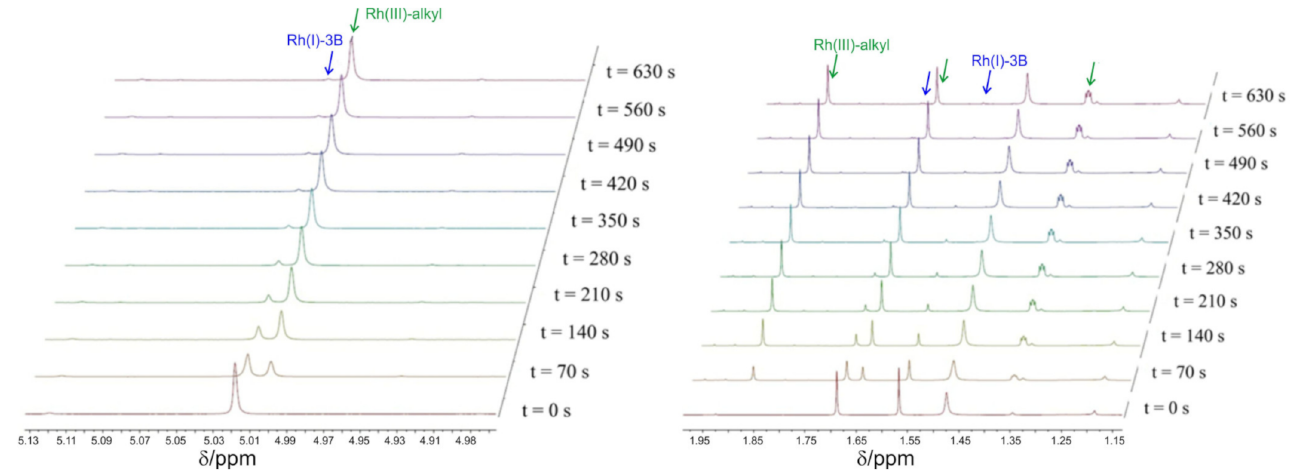
Figure 5. Stacked 1 H-NMR spectra of the reaction between the [Rh(CH 3 COCHCNPhCH 3 ) (CO)(PPh 3 )] 3B complex and CH 3 I, focusing on the methine ( left ) and methyl ( right ) proton signals at 25 ◦ C. The CH 3 I concentration (0.0502 mol dm − 3 ) was in a 10 ×